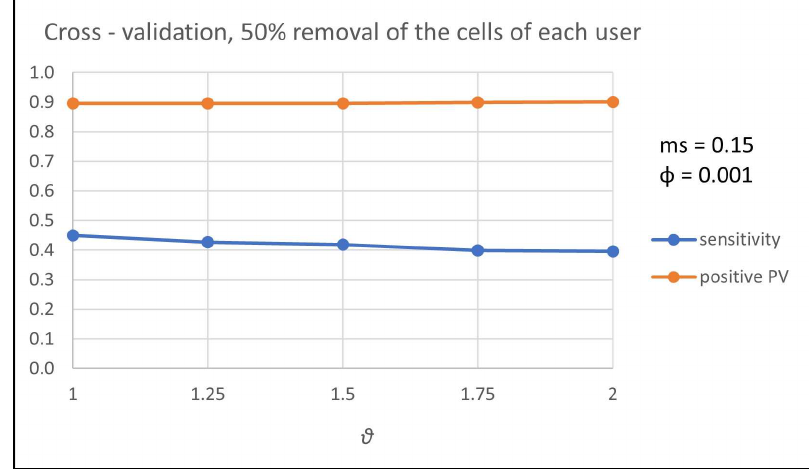
Figure 3. Cross-validation results (100% removal, with respect to minimum support).